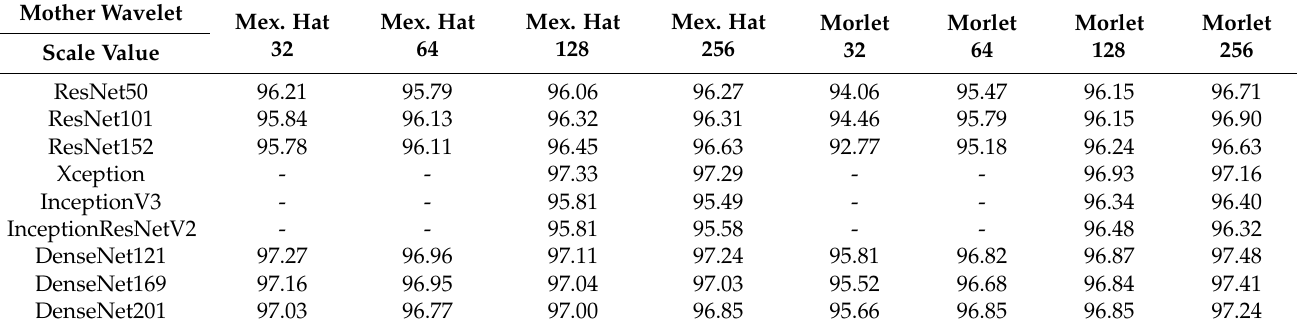
Table 1. The highest accuracy achieved in 5 attempts for each combination (in percentages).